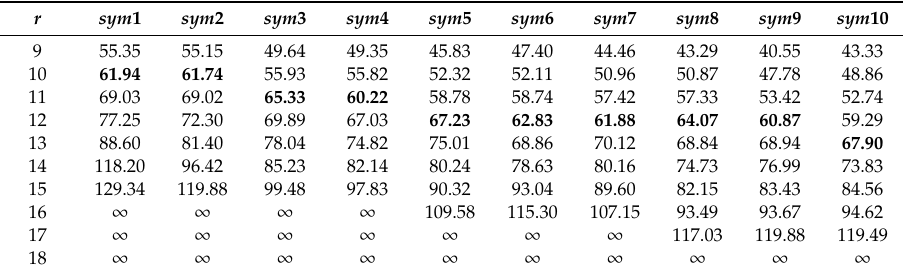
Table 21. Experimental results ( PSNR , dB) of 3D tomographic 12-bit image “Trufi_COR” DWT by using bit-width r of symlets filters coe ffi cients.